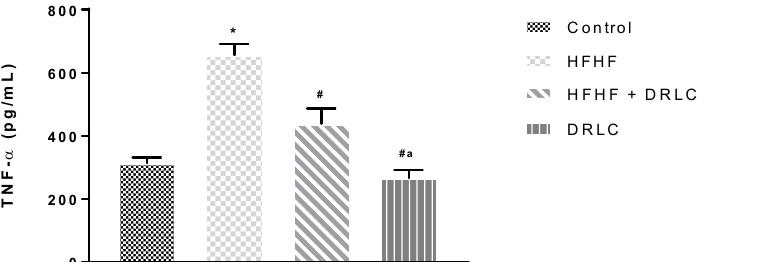
Figure 2. Serum TNF- α (Tumour necrosis factor—alpha). n = 5. Values were expressed as Mean ± SEM, * significantly different from control ( p < 0.05); # significantly different from HFHF ( p < 0.05); a significantly different from HFHF + DRLC ( p < 0.05). NB: Control, HFHF (high fructose high fat), HFHF + DRLC (D-ribose-L-cysteine) and DRLC in Wistar rats after 8 weeks of DRLC treatment.